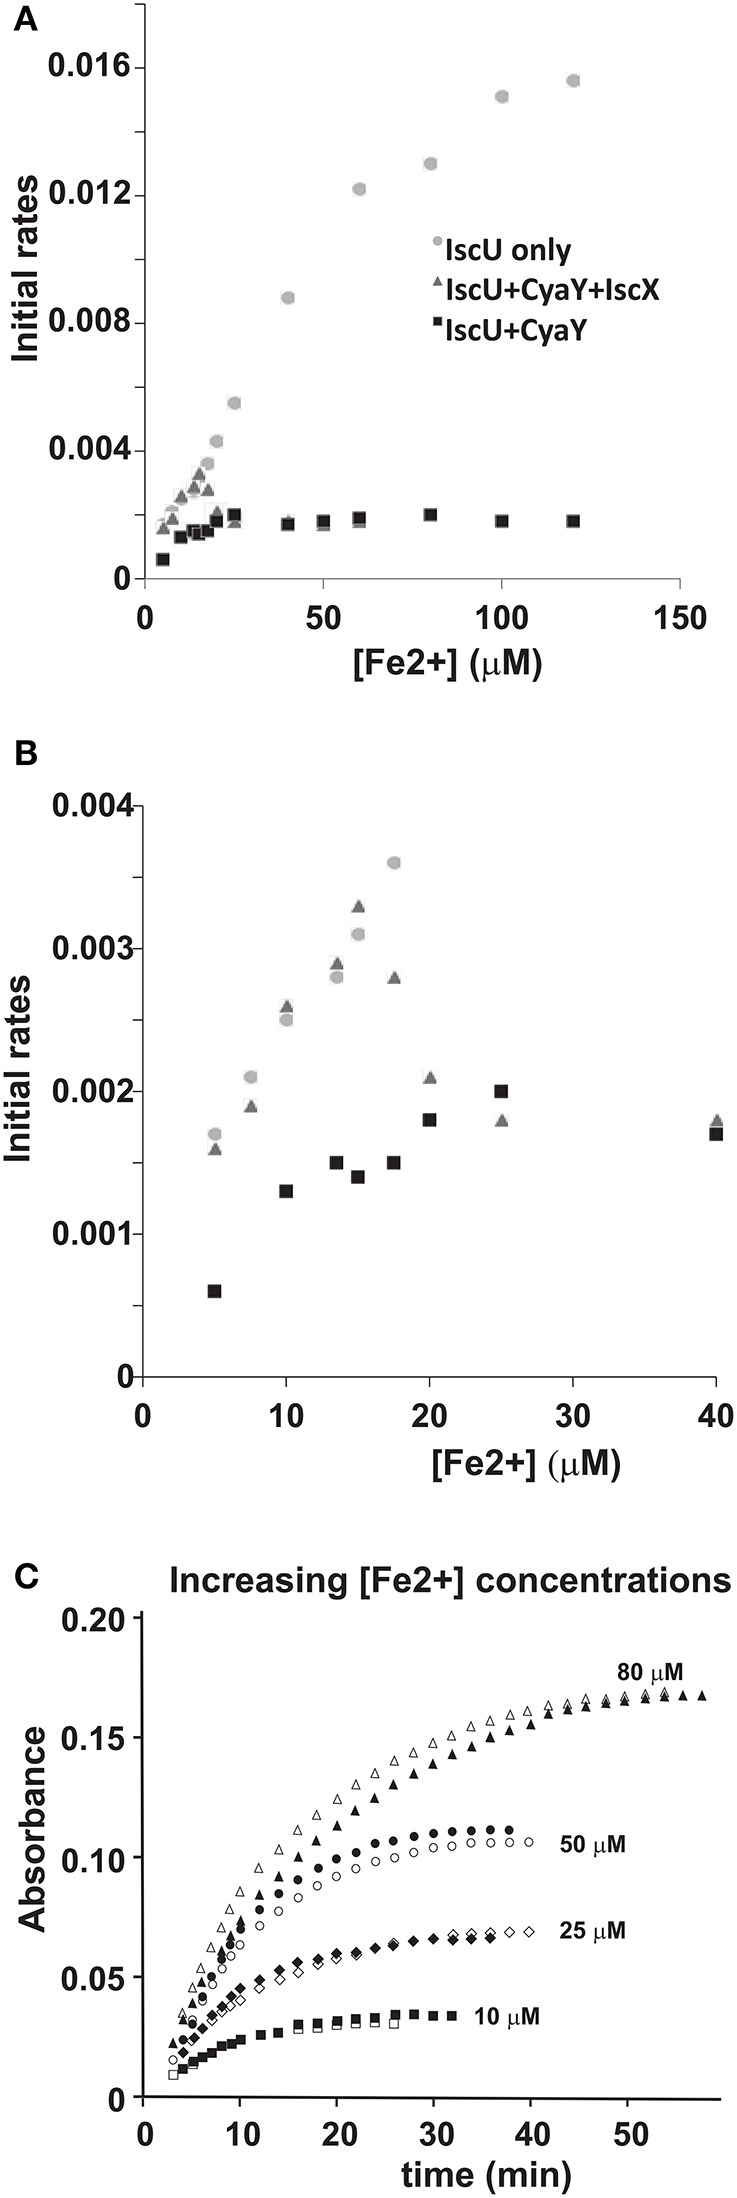
Iron dependence of the relative effect of CyaY and IscX on cluster assembly enzymatic kinetics on IscU. (A) Initial rates of kinetics of cluster formation on IscU as a function of iron concentration in the presence of IscU only (gray circle), IscU and CyaY (black rectangles) and IscU, IscX, and CyaY (gray triangles). (B) The same as in (A) but expanded for clarity. (C) Assays carried out in the absence and in the presence of IscX (1 μM) at increasing concentrations of iron (10 μM, 25 μM, 50 μM, 80 μM) to assess whether IscX is affected by iron. No CyaY was added to the assay. All experiment contained 1 μM IscS, 50 μM IscU, 250 μM Cys, 2 mM DTT.